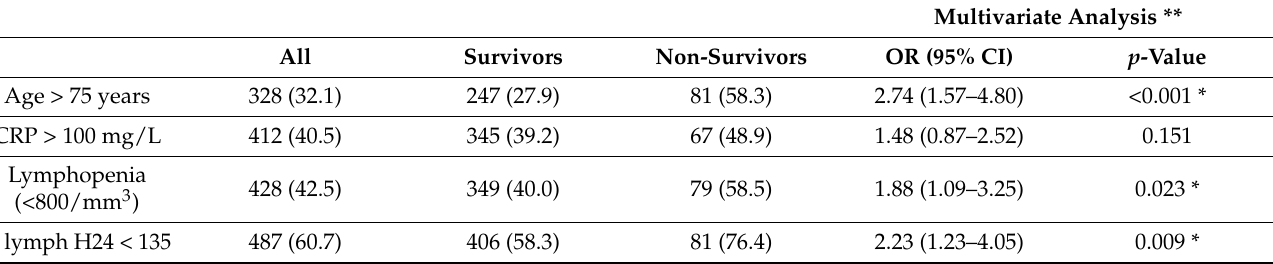
Table 3. Biochemical factors associated with mortality of